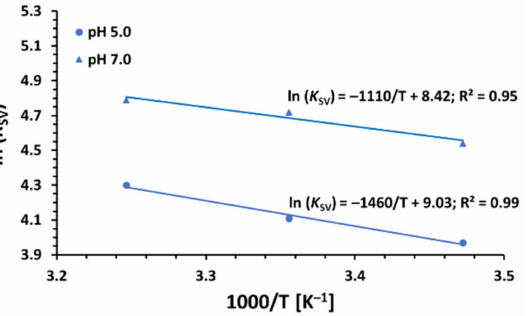
Figure 6. Van’t Hoff plots for the steady-state fluorescence quenching of BSA by CPC in 10 mM CACO buffer of pH 5.0 and